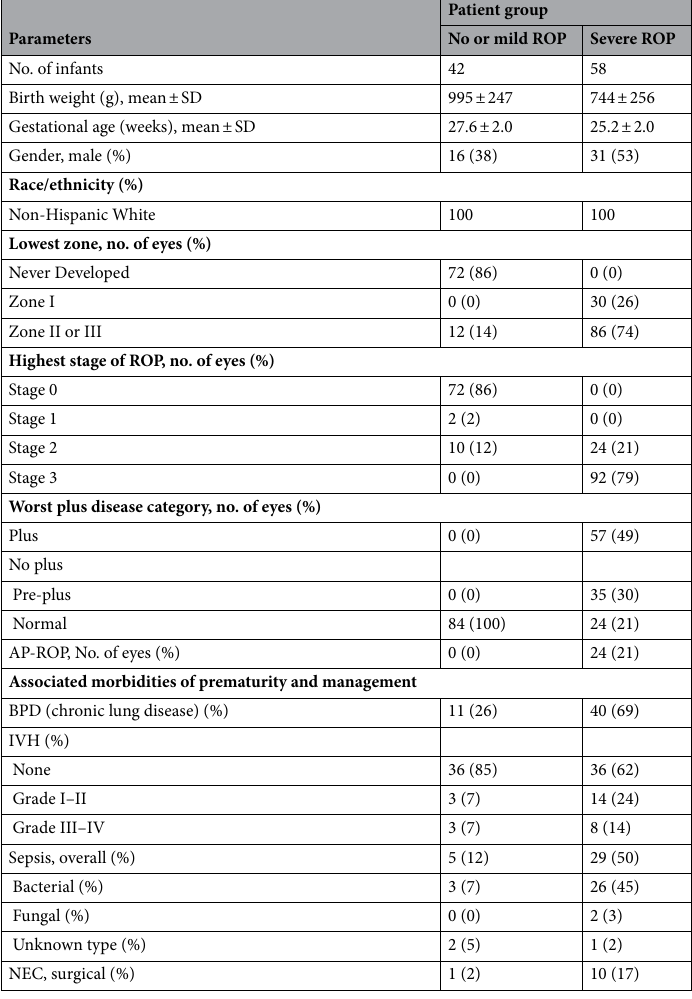
Table 1. Characteristics of subjects: demographics, retinopathy of prematurity characteristics, and associated morbidities of prematurity. + Two sample test of proportion. *Student two-sample T-test. ^Fisher exact table test. ROP retinopathy of prematurity, BPD bronchopulmonary dysplasia, IVH intraventricular hemorrhage, NEC necrotizing